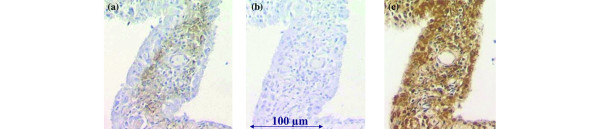
Localisation of citrullinated proteins in synovial membranes. (a) Immunostaining of citrullinated proteins by the anti-modified citrulline kit was mainly confined to the subsynovium. (b) No staining was visible on the control. (c) Staining produced by the anti-α-enolase antibody on an adjacent section was much stronger, and included the subsynovial cells which also stained for citrullinated antigens. Original magnification × 20 in all cases.